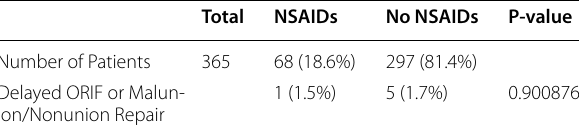
Table 4 Patients with 5 th MT Fractures Initially